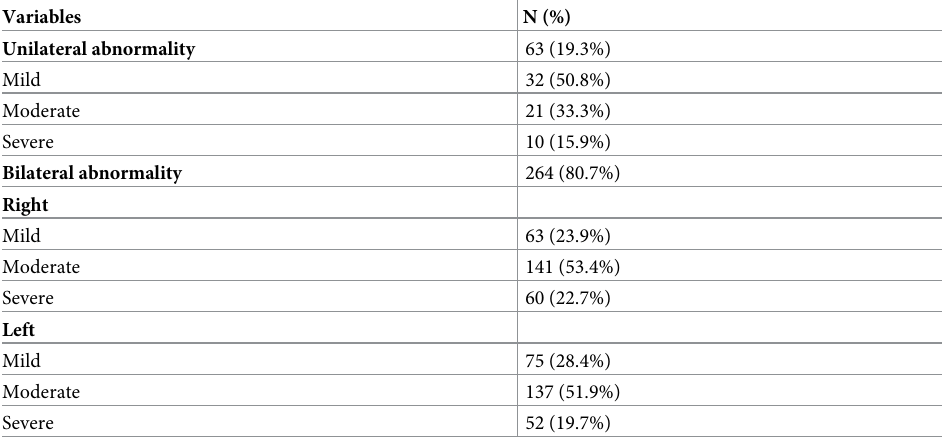
Table 2. Nerve conduction study results in 327